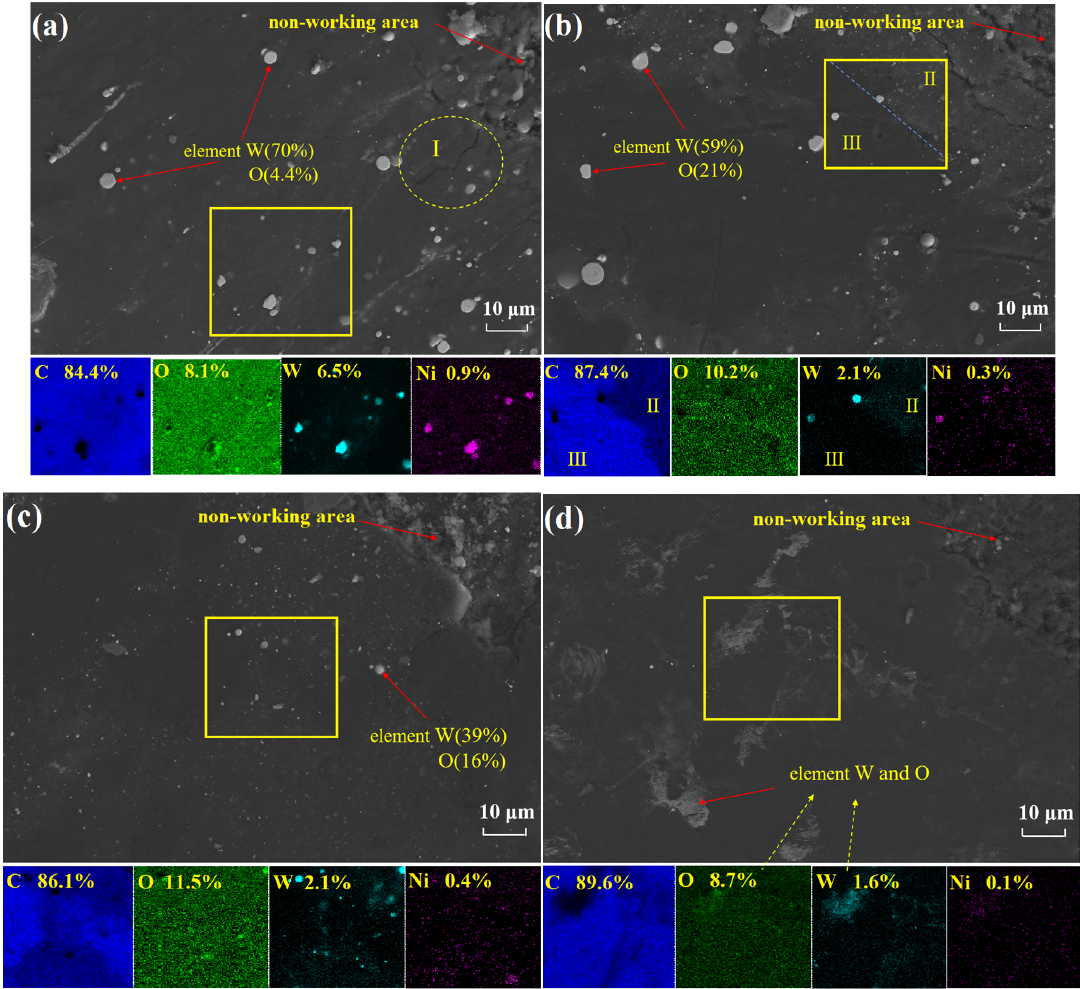
Figure 5. SEM of PRG pin under different temperatures: ( a ) RT; ( b ) 200 °C; ( c ) 300 °C; ( d ) 400 °C.